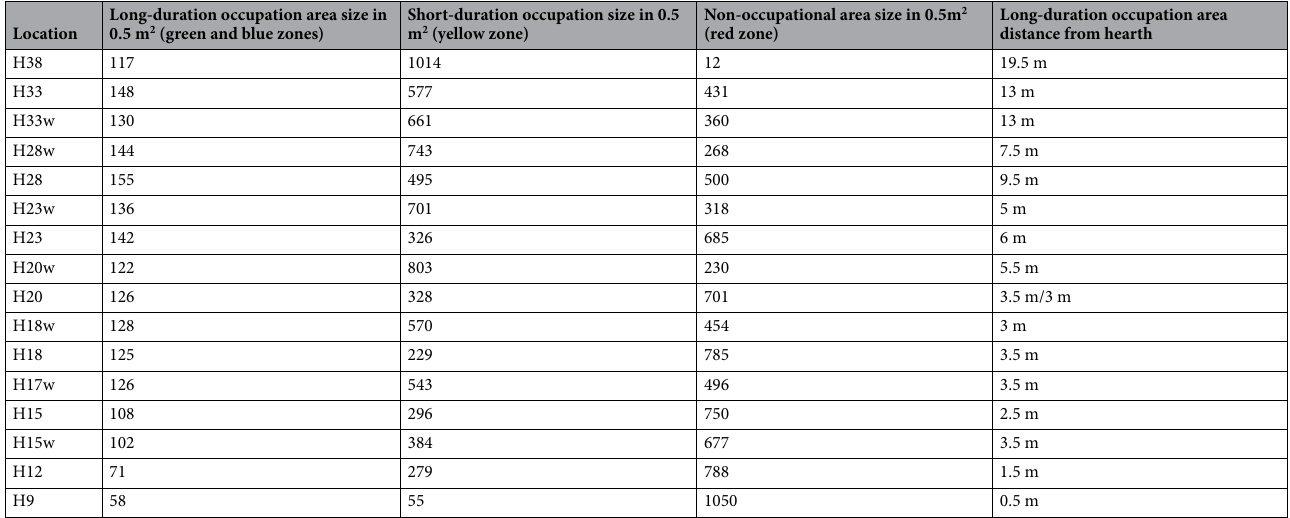
Table 2. Results for smoke density from sensors at 1 m height.